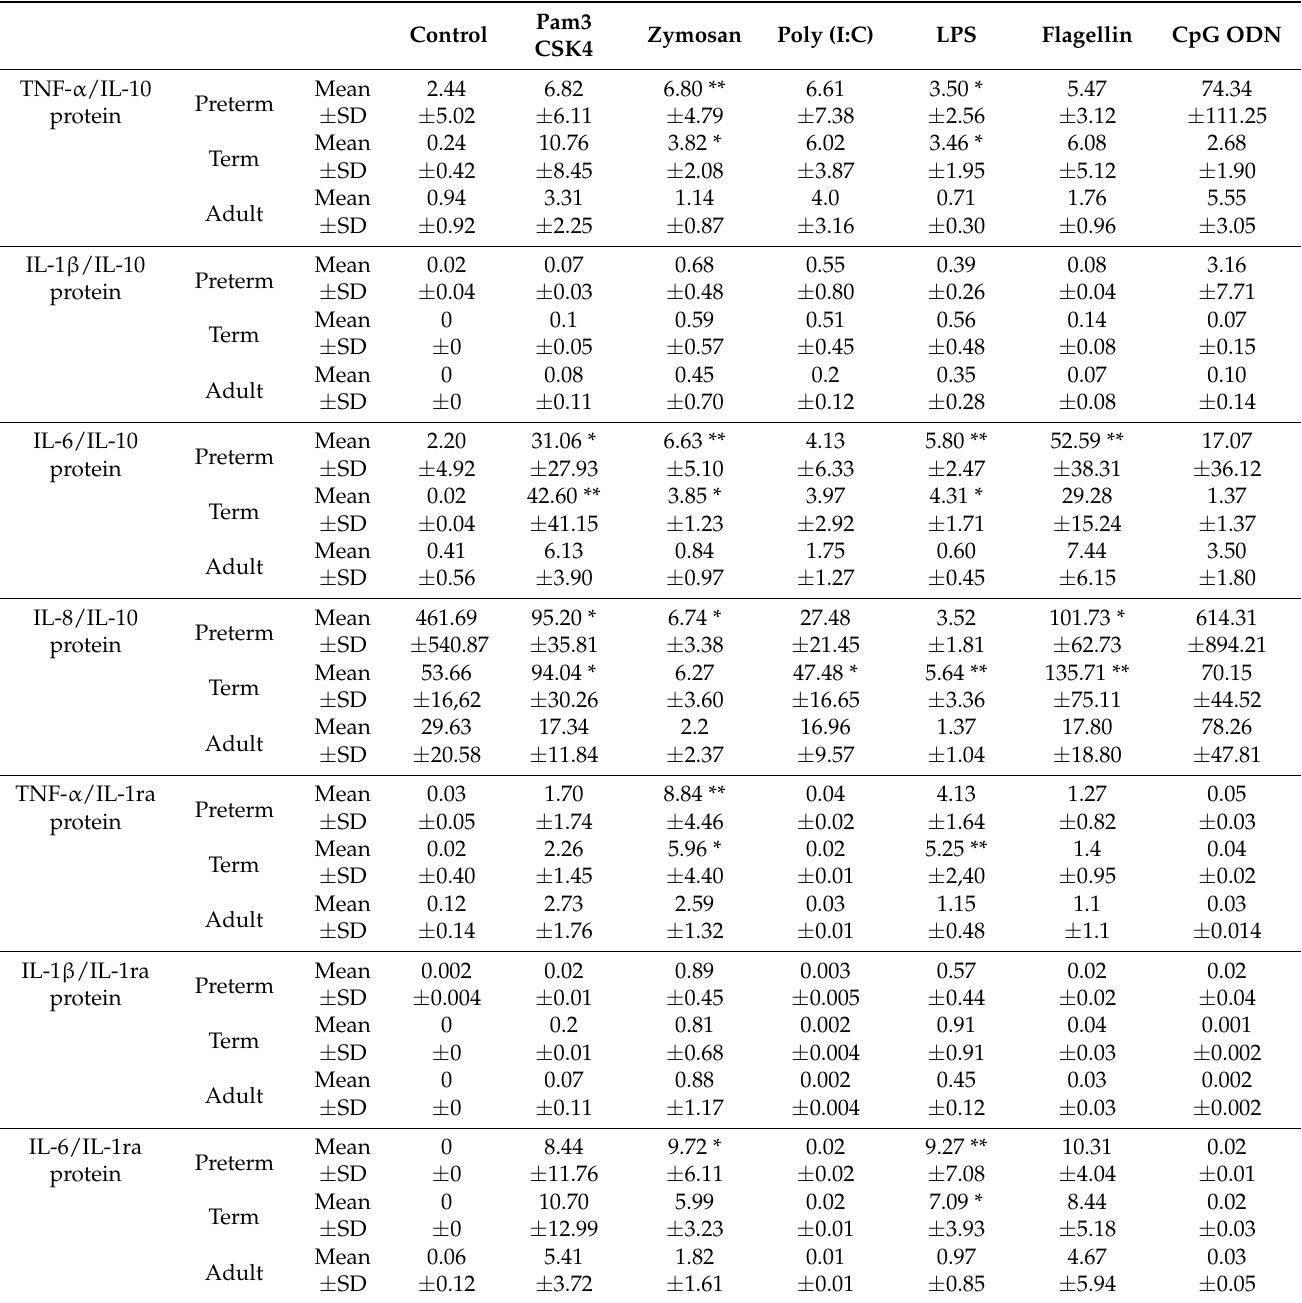
Table 2. Ratios of pro-inflammatory to anti-inflammatory